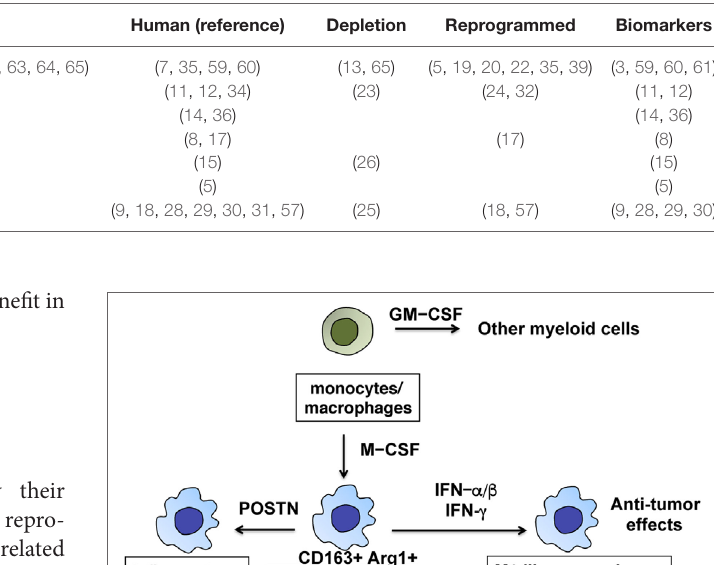
TAble 1 | Tumor-associated macrophages in skin cancer: mouse and human